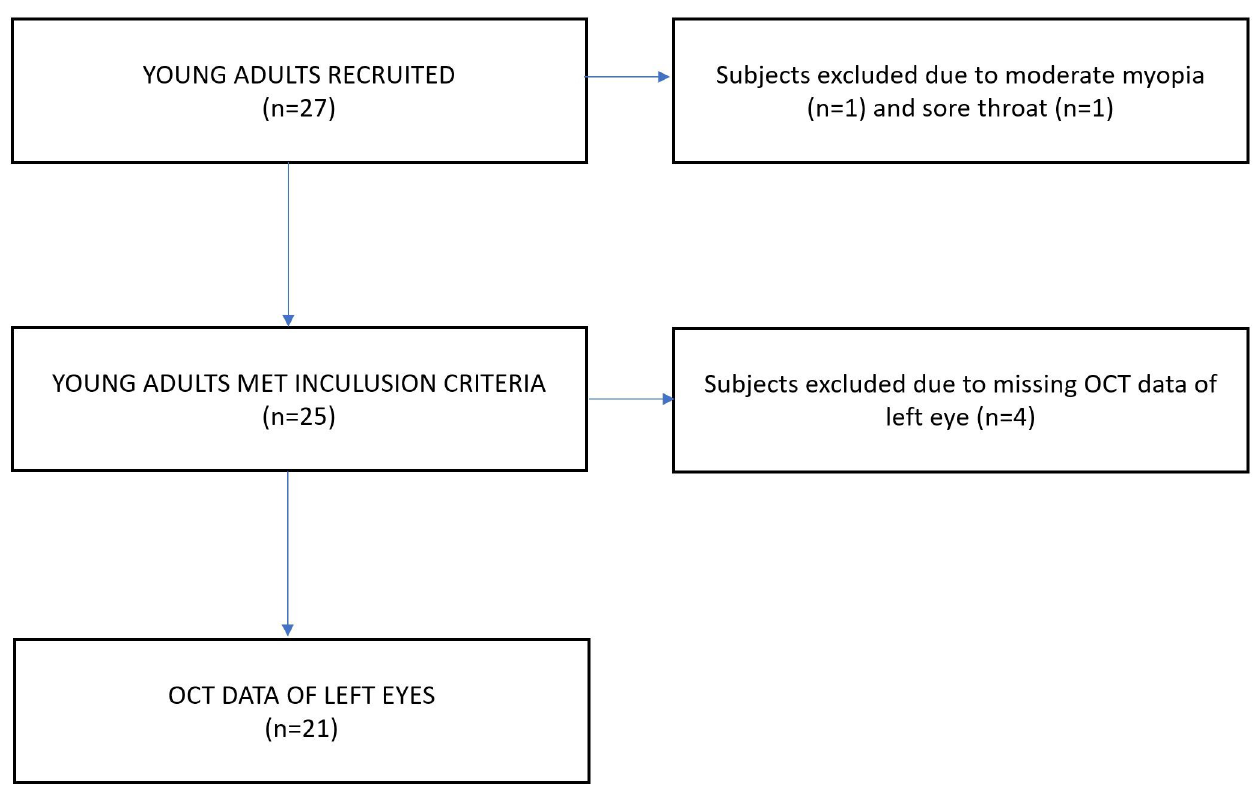
Fig 1. Flowchart highlighting the recruitment process and the number of individuals included/excluded in the